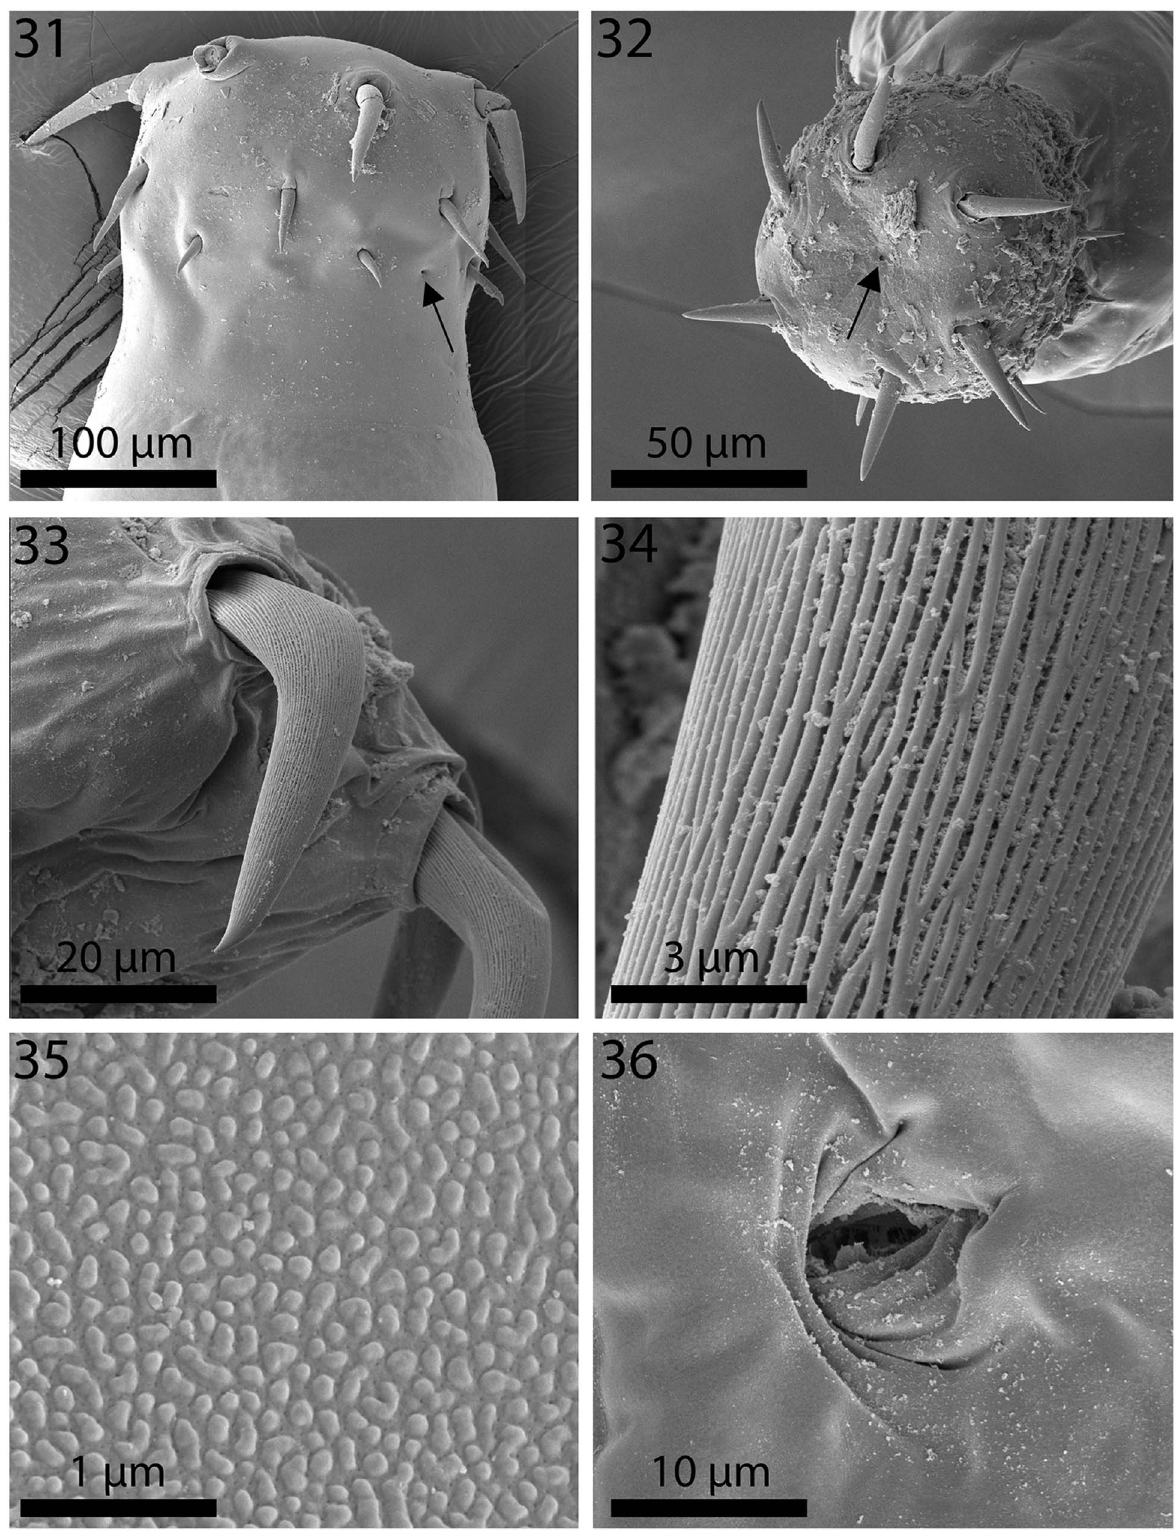
Figures 31 – 36. SEM of specimens of Neoechinorhynchus ponticus n. sp. from Chelon auratus from the Black Sea. 31. The proboscis and neck of a male specimen showing the comparatively smaller hooks than in N. personatus and one of the neck sensory pores (arrow). 32. An apical view of a proboscis showing the pore of the apical organ (arrow). 33. The longitudinally serrated anterior proboscis hook of a specimen. 34. Detail of the serration pattern on the hook shown in Figure 33. 35. Detail of the pebbled surface of the neck of a specimen. 36. Detail of the female